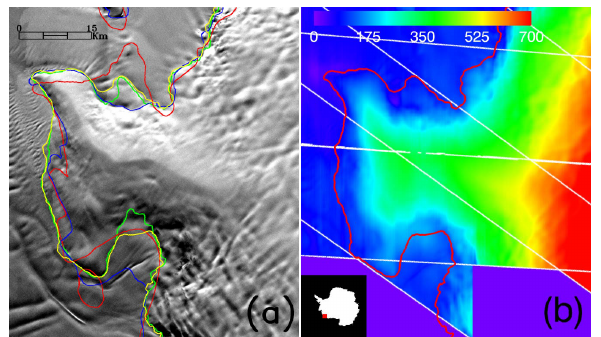
Figure 3. Section of Antarctic coast (Scott Peninsula along Bakutis Coast) approximately 60 km x 69 km. (a) Enhanced Landsat image comparing various image ‐ based mappings of the “grounding line” or grounded ice boundary: red, Antarctic Digital Database; blue, USGS Coastal Change map series; green, MODIS Mosaic of Antarctica; yellow, ASAID. (b) Color ‐ coded surface elevations (in meters above mean sea level) derived from ASAID application of photoclinometry using image on left and GLAS elevation profiles. Thin white lines show the location of GLAS profiles interpolated by photoclinometry. ASAID grounded ice boundary from (a) is reproduced (now in red).